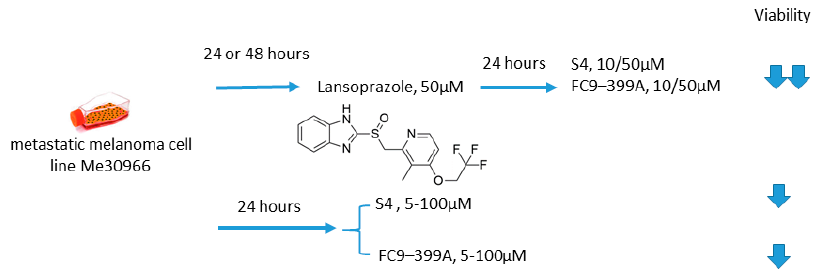
Figure 19. Graphical outline of the study on S4/FC9–399A +lasoprazole combination reported by Federici et al.